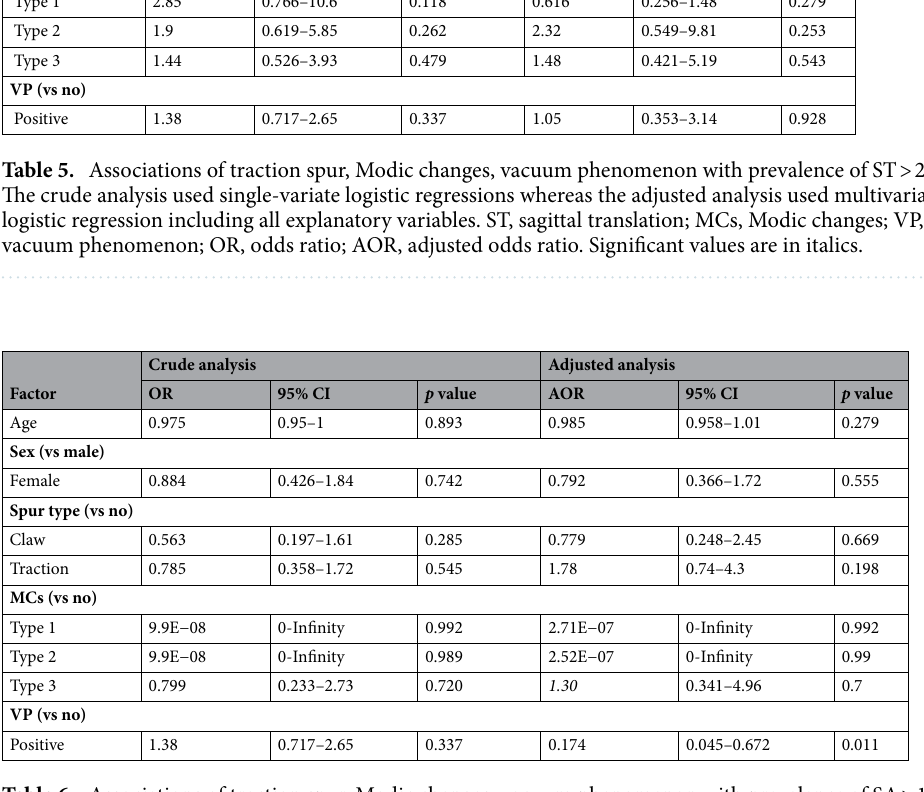
Table 6. Associations of traction spur, Modic changes, vacuum phenomenon with prevalence of SA > 10 degree. The crude analysis used single-variate logistic regressions whereas the adjusted analysis used multivariate logistic regression including all explanatory variables. SA, sagittal angulation; MCs, Modic changes; VP, vacuum phenomenon; OR, odds ratio; AOR, adjusted odds ratio. Significant values are in